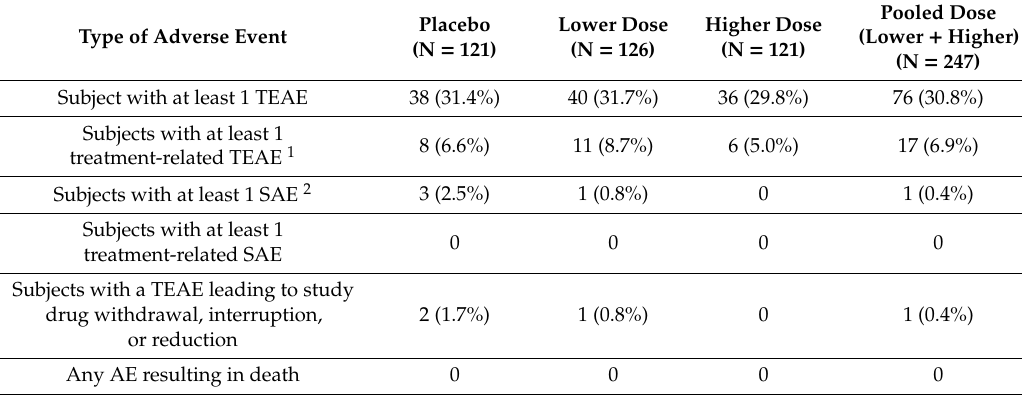
Table 5. Overall Summary of Treatment-Emergent Adverse Events (Safety Population).